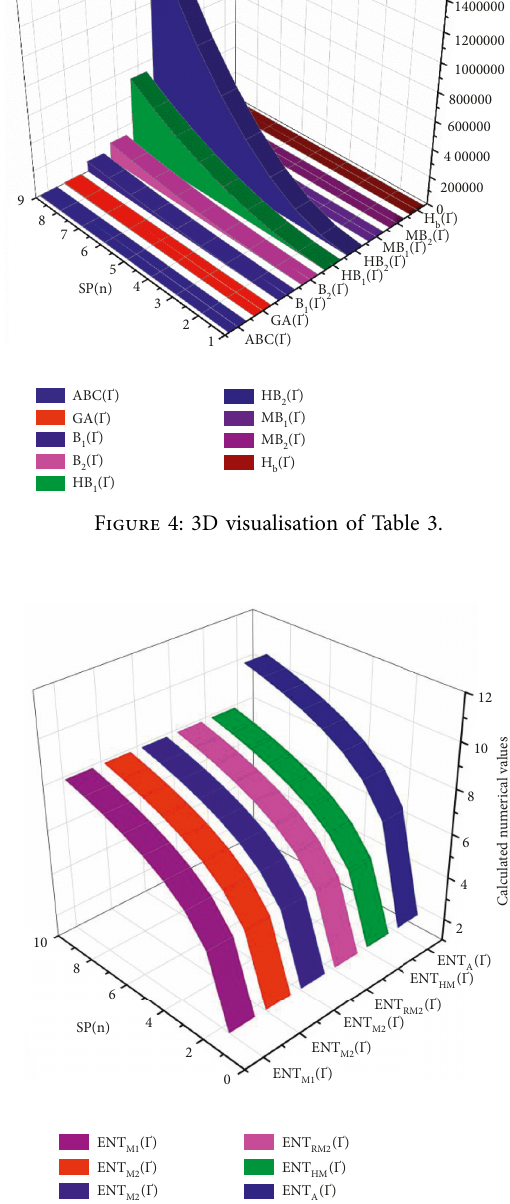
Figure 5: 3D visualisation of Table 4.